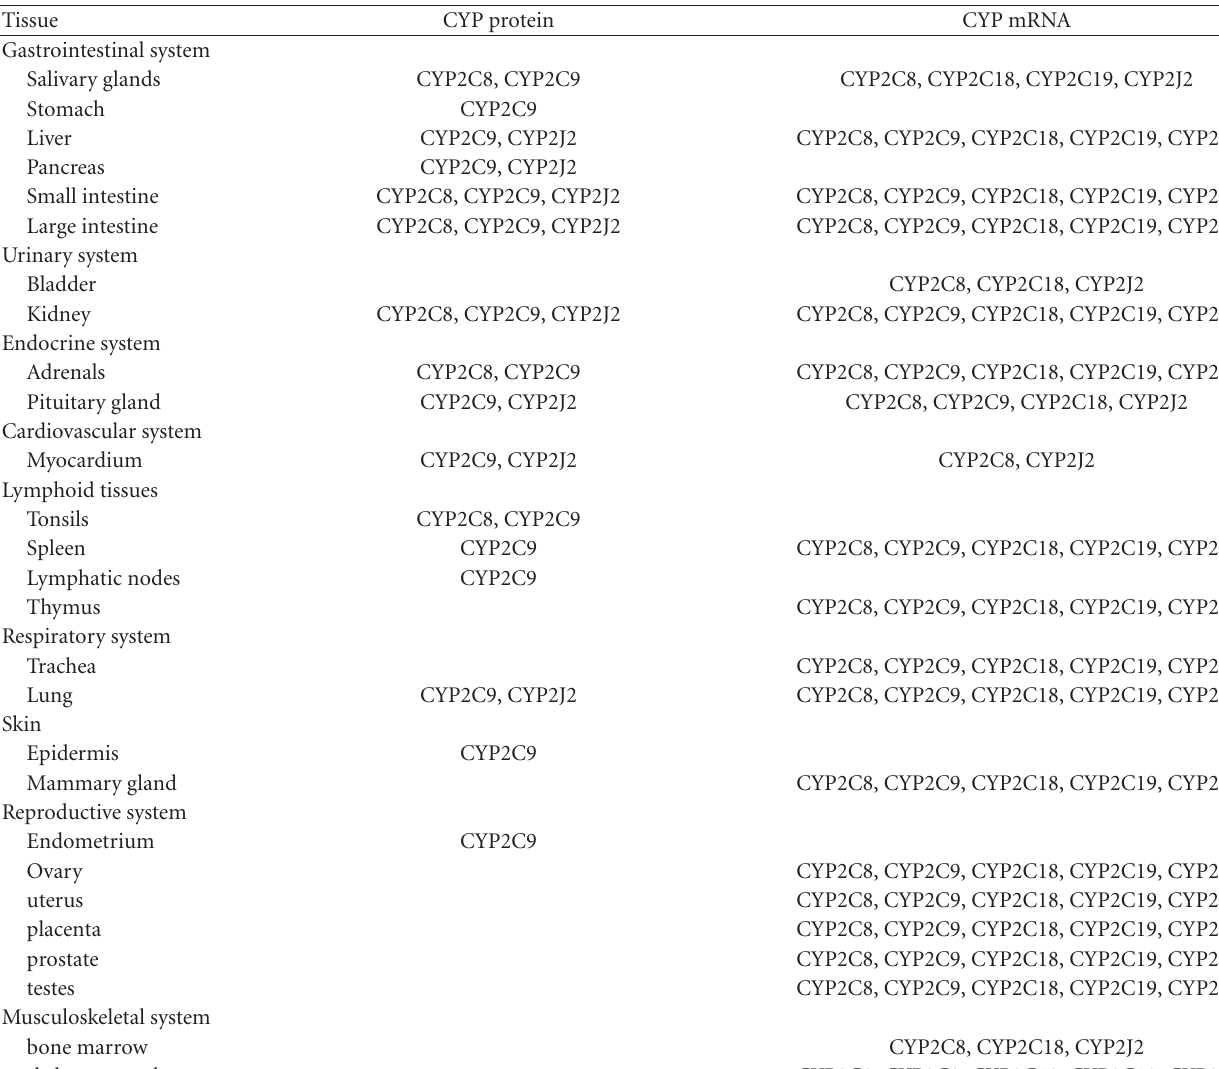
Table 2: Summary of CYP2C and CYP2J2 expression in normal adult tissues. Expression levels estimated at protein and mRNA level [23,